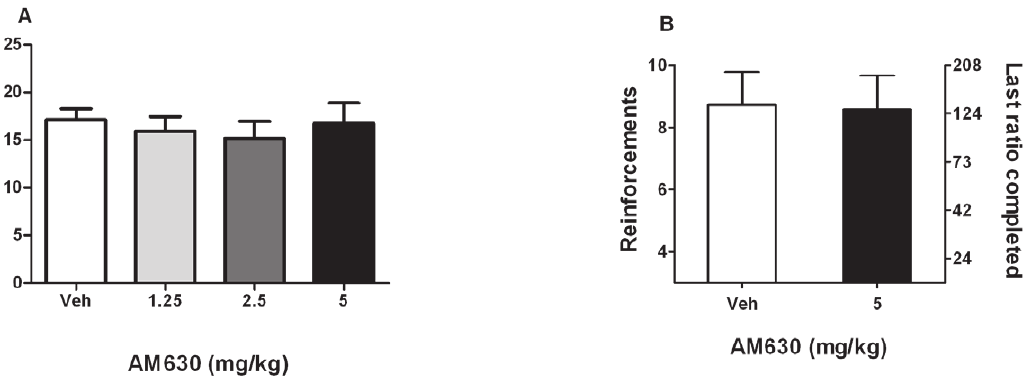
Figure 4. Effect of AM630 on nicotine self administration under FR5 and PR schedules of reinforcement. A . Effects of pretreatment with AM630 (1.25, 2.5 and 5 mg/kg, IP, H 30) on nicotine (30 m g/kg/infusion) self administration under the FR5 schedule. Data are expressed as means ( 6 SEM) of the number of nicotine infusions obtained during the 60-min session. AM630 did not affect responding vs. vehicle (0 mg/kg) pretreatment (N=12); P=0.67. B . Effects of pretreatment with AM630 (5 mg/kg, IP) on nicotine (30 ug/kg/infusion) self administration under PR schedule. A , Data are expressed as means ( 6 SEM) of the number of nicotine infusions obtained during the 4-hr sessions. AM630 did not affect break point P . 0.05 vs. vehicle (0 mg/kg) pretreatment. (N=7) P=0.73.